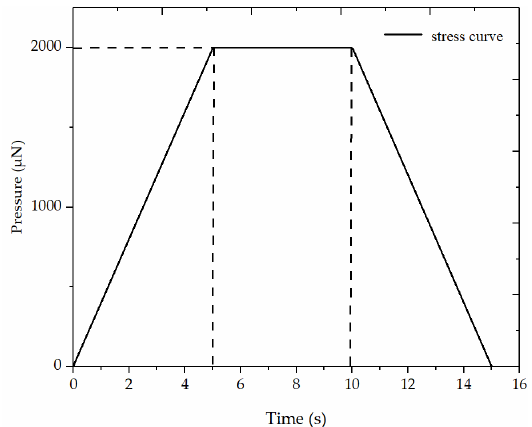
Figure 13. Applied nanoindentation stress curve.